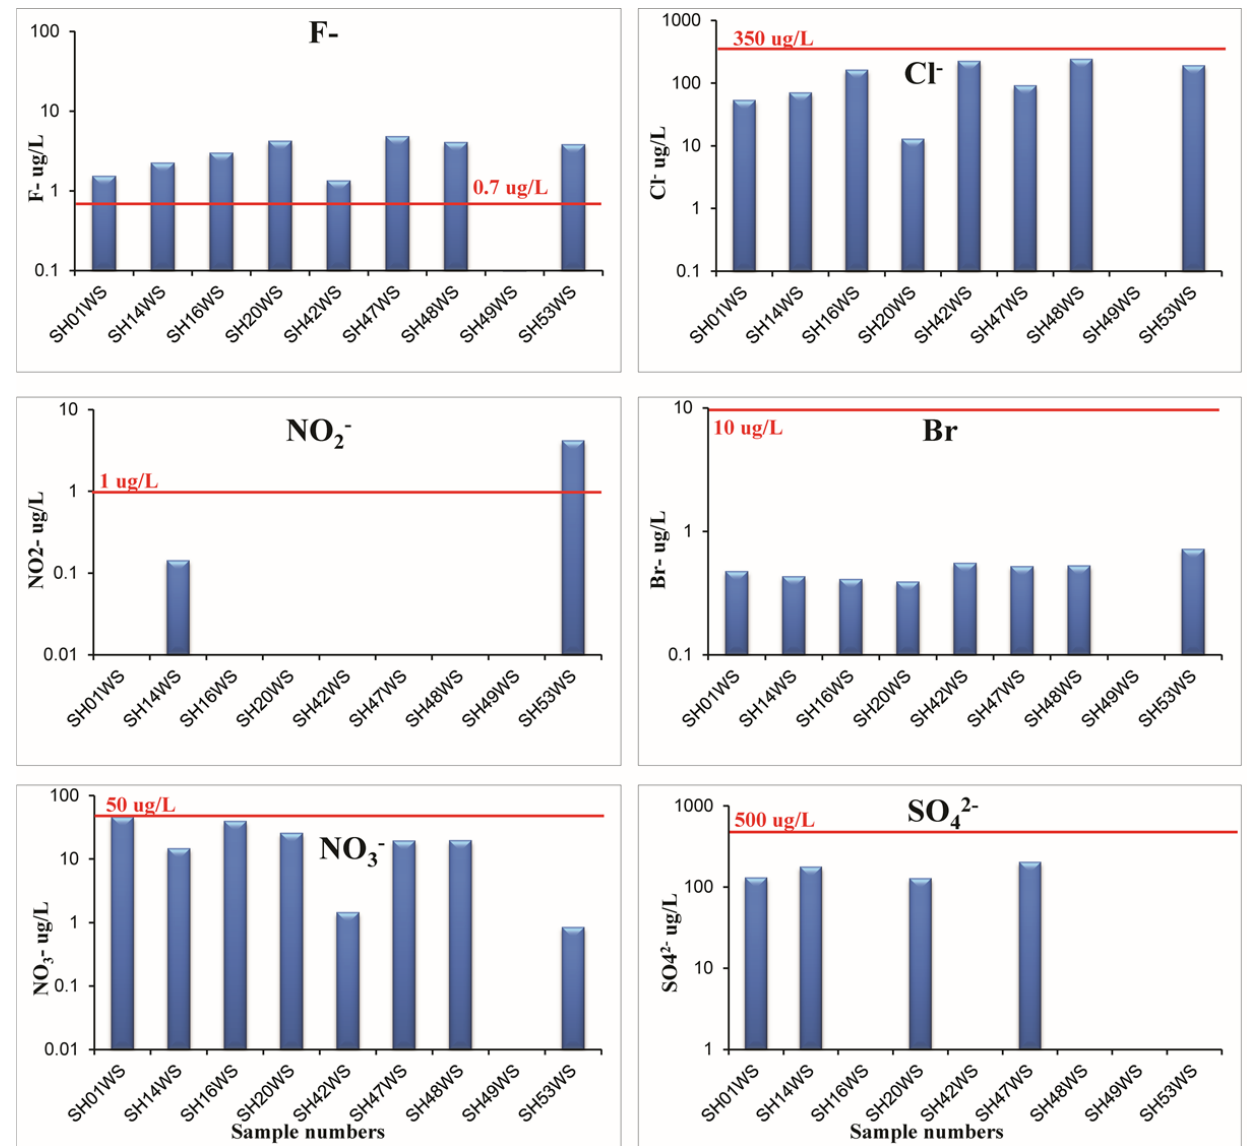
Fig. 6. Сomparison of the drinking water standard of Mongolia with anion content of water samples from the wells in the Shuteen area. The red line shows the permissible limit of drinking water (Batkhishig et al.,